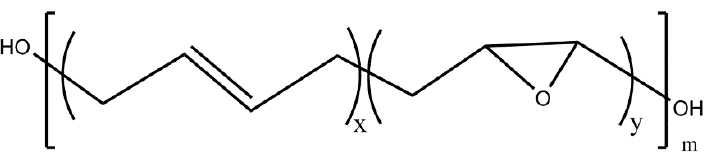
Figure 1. Chemical structure of HTPB.